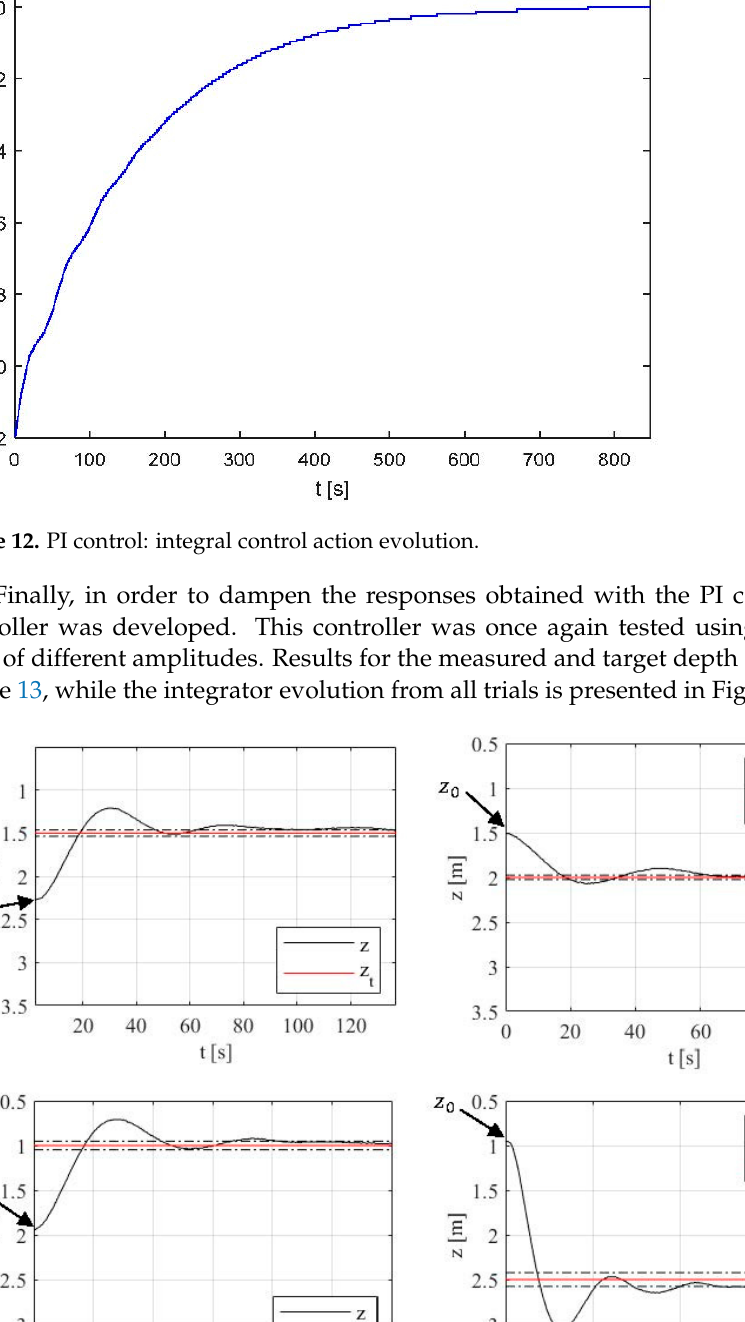
Figure 11. PI control, step response to evaluate steady state error: z is the BCD depth, z t is the target depth and the dashed dot lines represent a ±5% band around z t.